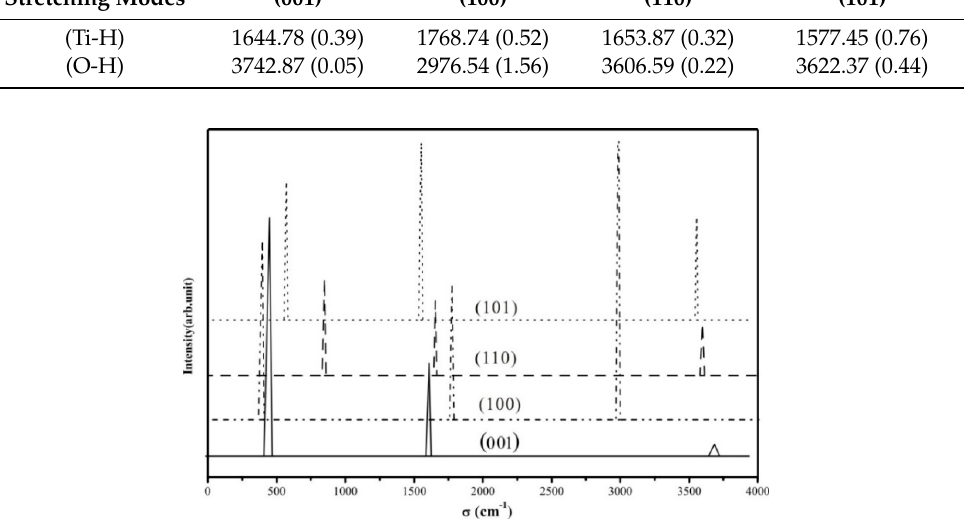
Table 5. Computed IR wavenumbers (cm − 1 ) and intensities (in brackets) of Ti − H and O − H stretching modes of (H + , H − ) species for the four terminations studied.